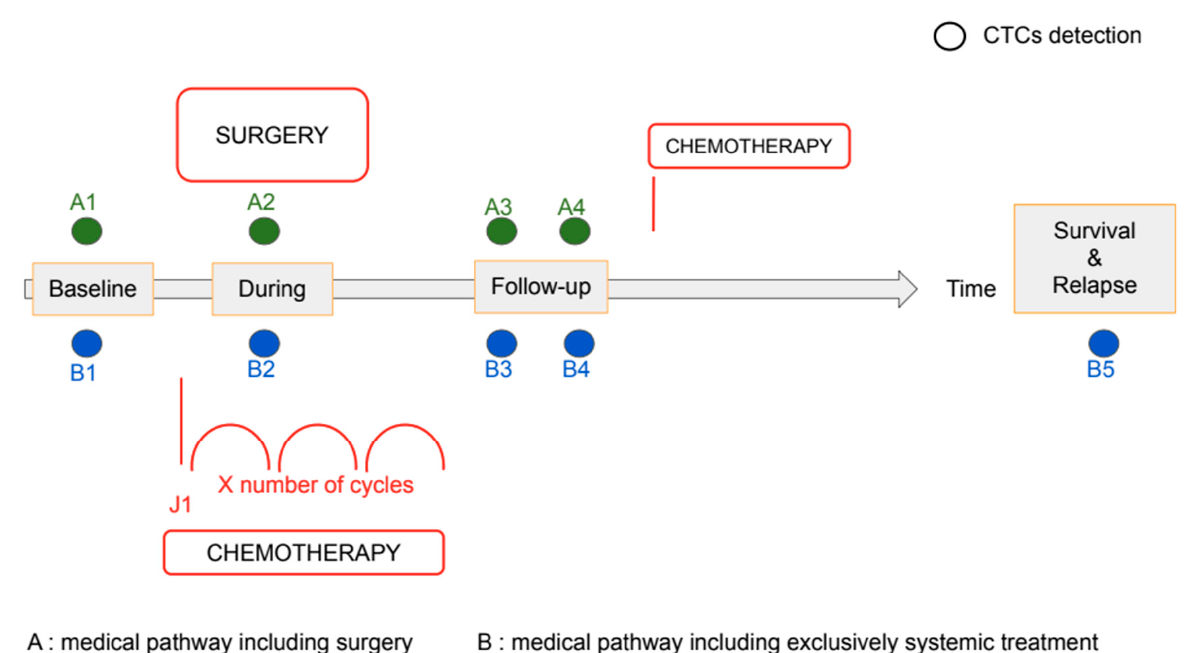
Figure 3. Time point for CTCs detection for colon cancer without neo-adjuvant treatment.